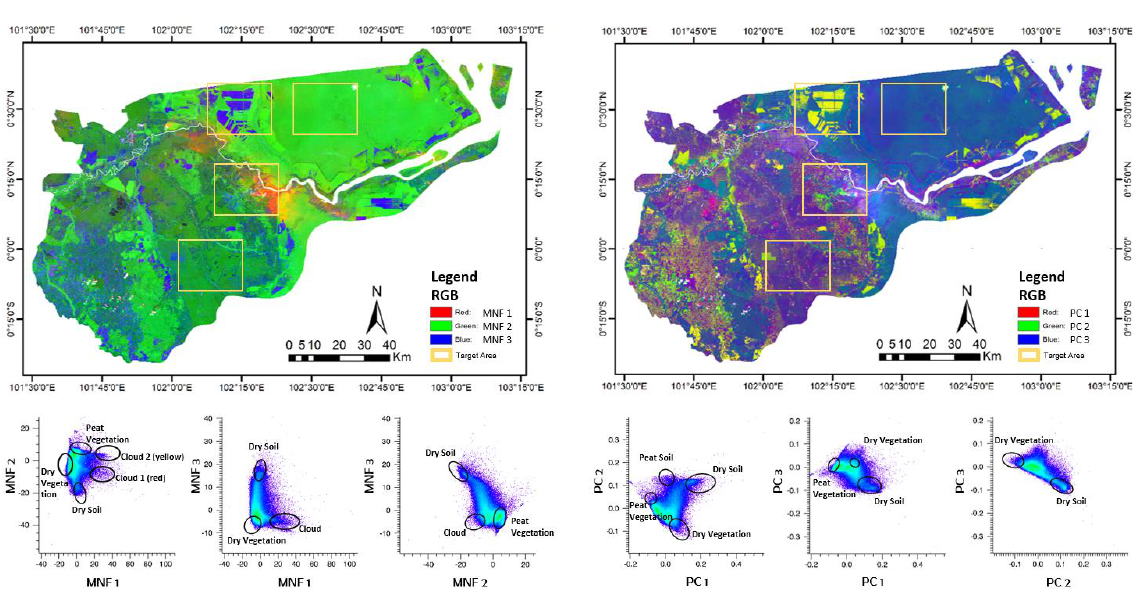
Figure 5. Comparison between PCA transformations and the first-three components result (right) and MNF transformations and the first-three components result (left) on global scatterplot analysis endmember reflectance spectra identified through the analysis of the